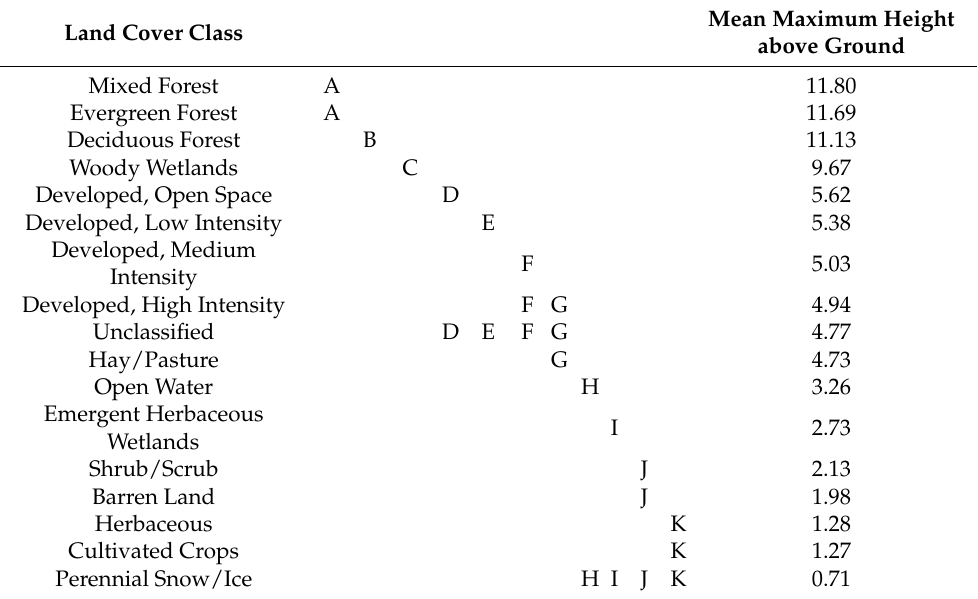
Table 15. Mean maximum height above ground (3-m pixel) by 2019 USGS National Land Cover Dataset land cover class. Land cover classes not connected by the same letter are significantly different.